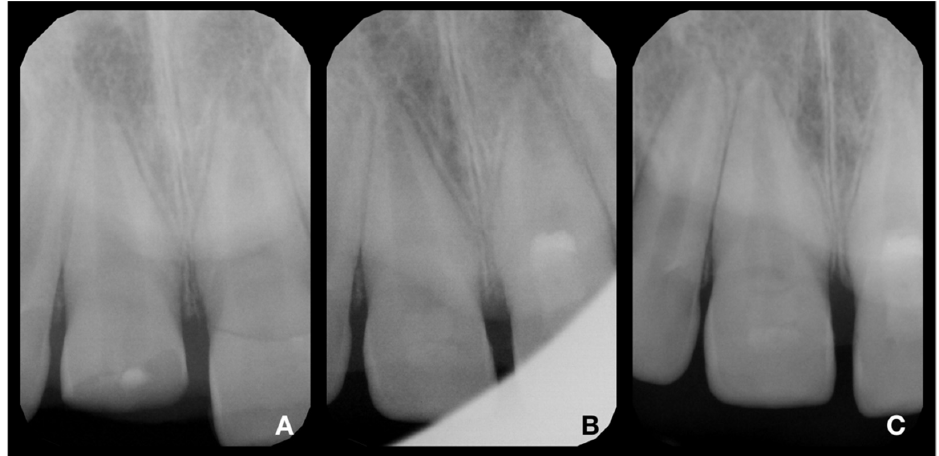
Figure 4. X-rays of tooth 11. ( A )—diagnostic X-ray of tooth 11; ( B )—postoperative X-ray of tooth 11; ( C )—control X-ray at 24-month follow-up. The continuing development of the root and narrowing of the root canal is visible. In addition, the formation of a radiopaque bridge under the calcium silicate cement and the absence of periapical radiolucency are apparent.